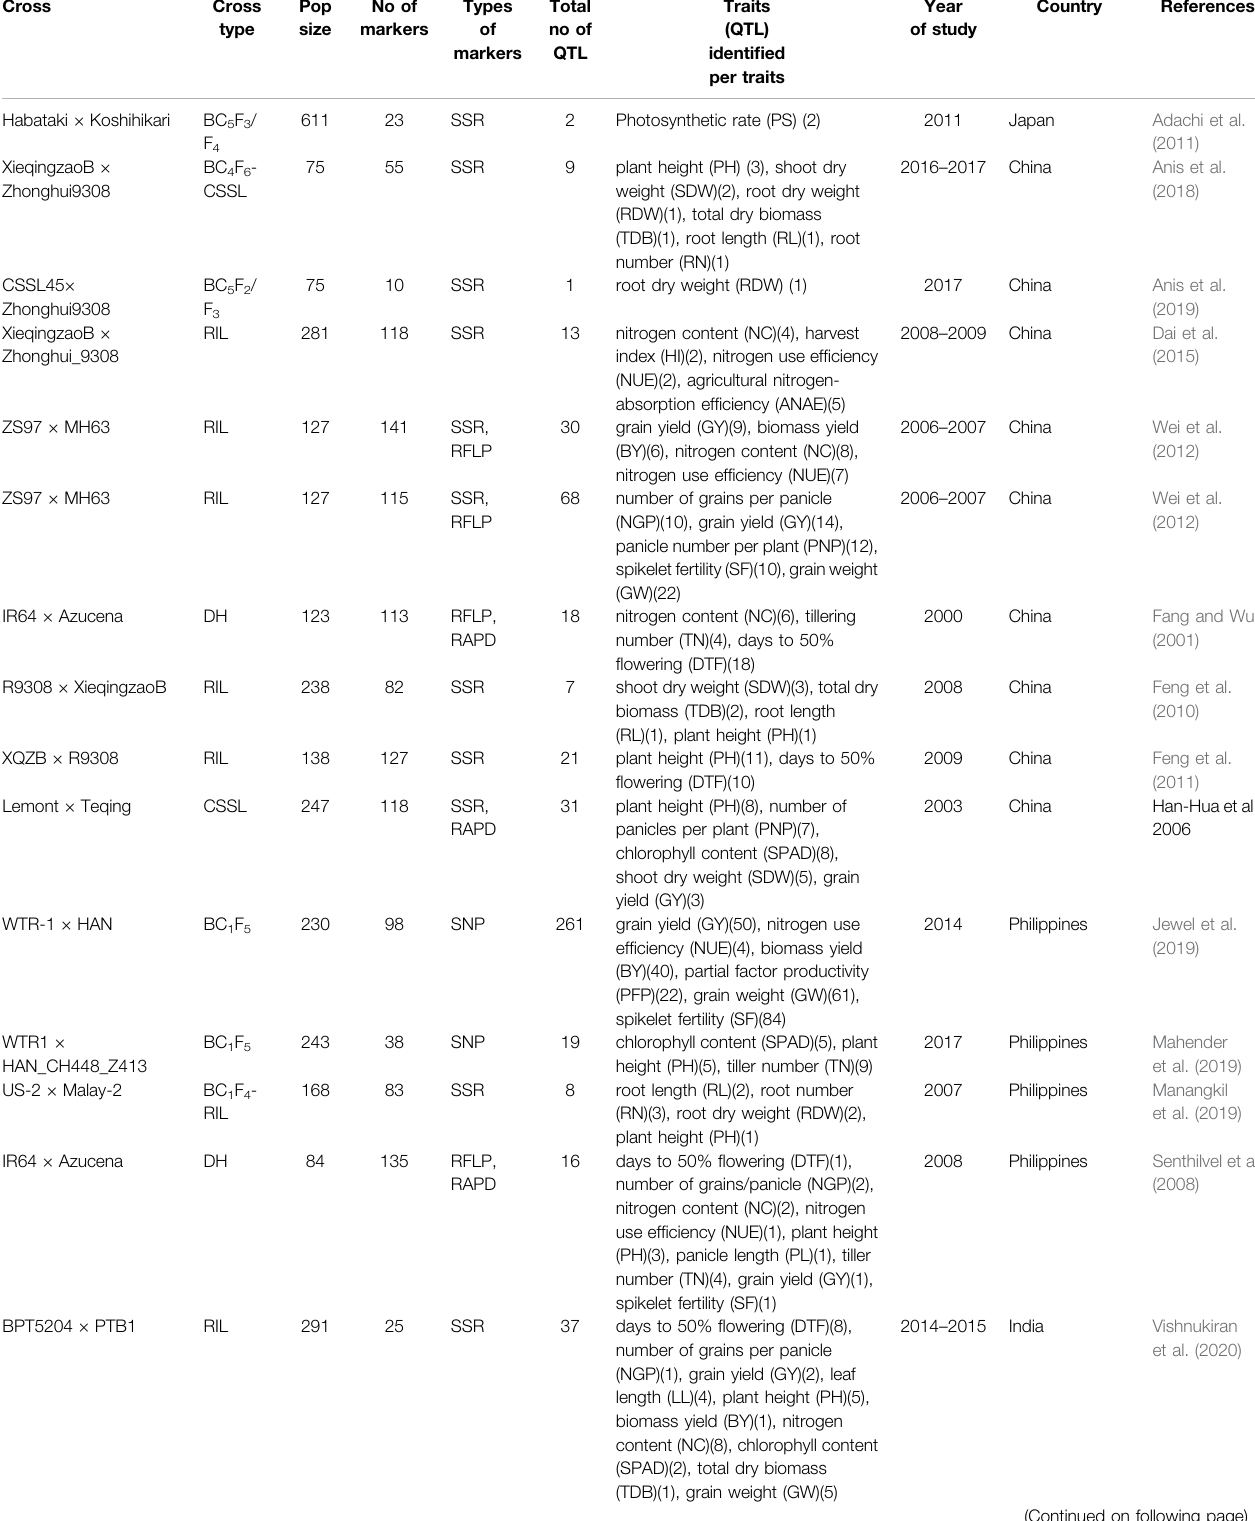
TABLE 1 | Summary of the QTL studies used in the QTL meta-analysis for the nitrogen use ef fi ciency and related traits in rice.